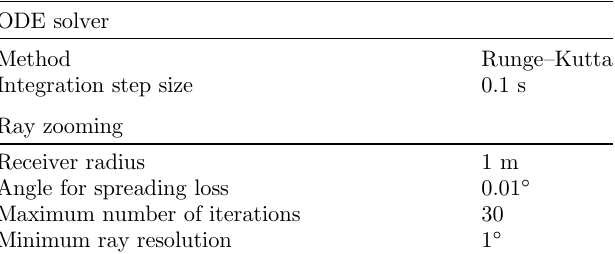
Figure 7. Comparison of ray propagation using the ART model (solid lines) and the model by Wilson [29] (dashed lines) for three different wind directions. Note that the differences between solid and respective dashed lines are so small that they are not visible. (a) Downwind ( v dir = 1, 0, 0]). (b) Upwind ( v dir = (cid:2) 1, 0, 0]). (c) Sidewind ( v dir = 0, 1, 0]), side view. (d) Sidewind ( v dir = 0, 1, 0]), bird ’ s- eye view. Table 2. Simulation settings for ART framework used through- out this